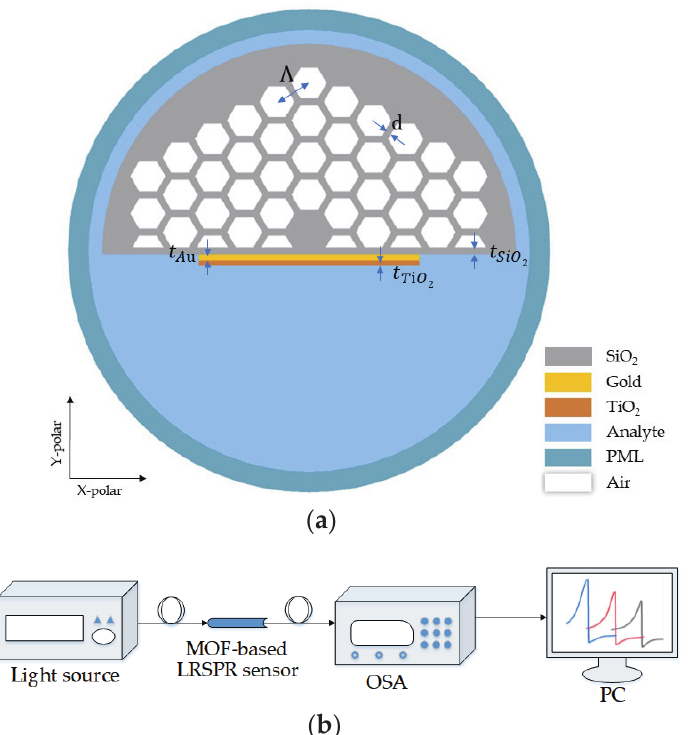
Figure 1. ( a ) Cross-sectional schematic structure of the D-shaped LRSPR refractive index sensor with SiO 2 -Au-TiO 2 structure. ( b ) Diagram for the experimental setup for sensor characterization. Λ denotes the pitch of MOF’s air-hole cladding; d denotes the thickness of silica web; t Au denotes the thickness of gold film; t TiO denotes the thickness of the tin oxide film; t SiO denotes the thickness of the planar 2 2 silica layer; PML: perfectly-matched layer; OSA: optical spectrum